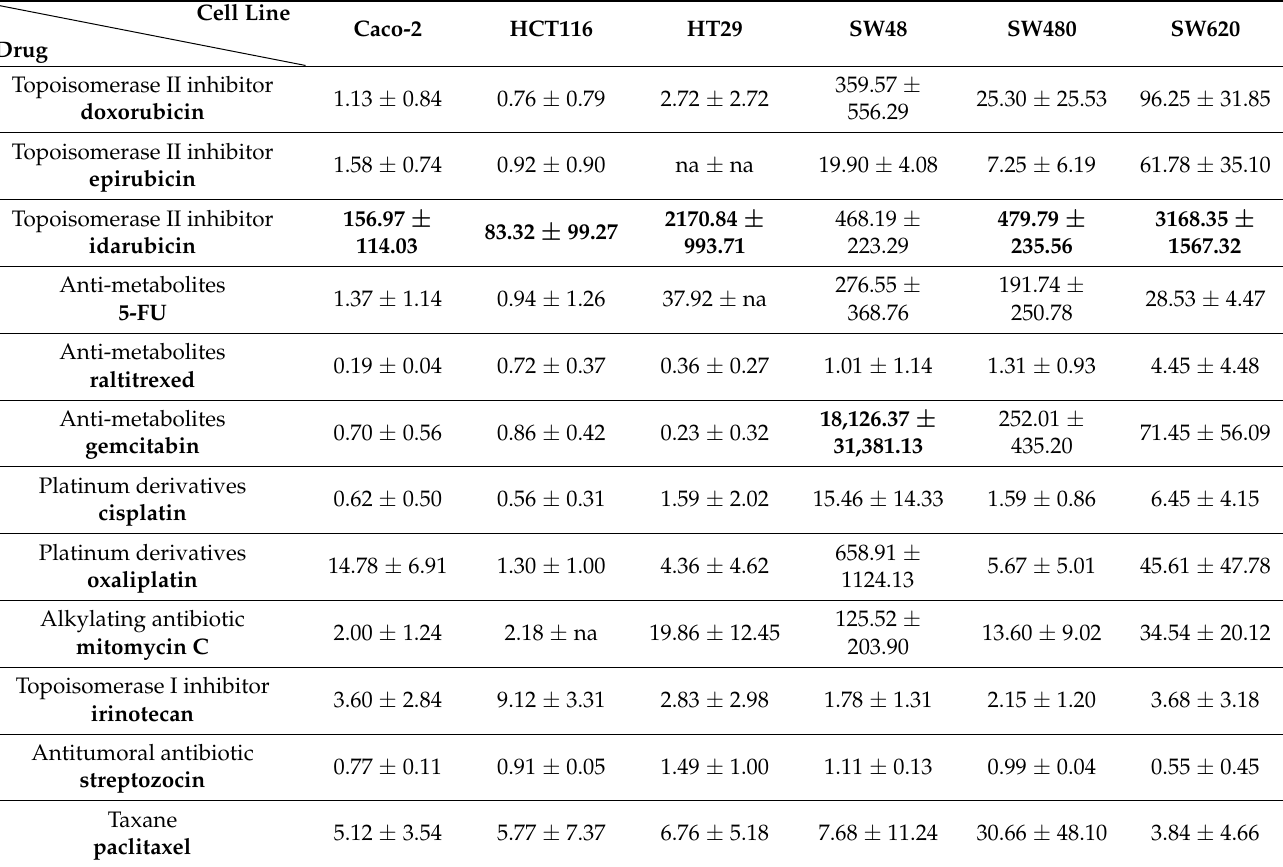
Table 3. Cytotoxic Index (CyI 90 ) values (mean ± standard deviation) obtained for the 6 colorectal cancer cell lines and the 12 antitumoral agents. The bold is to underline the name of the drug, distinguish from the family of the drug. Numbers in bold are the highest values for each column (cell line